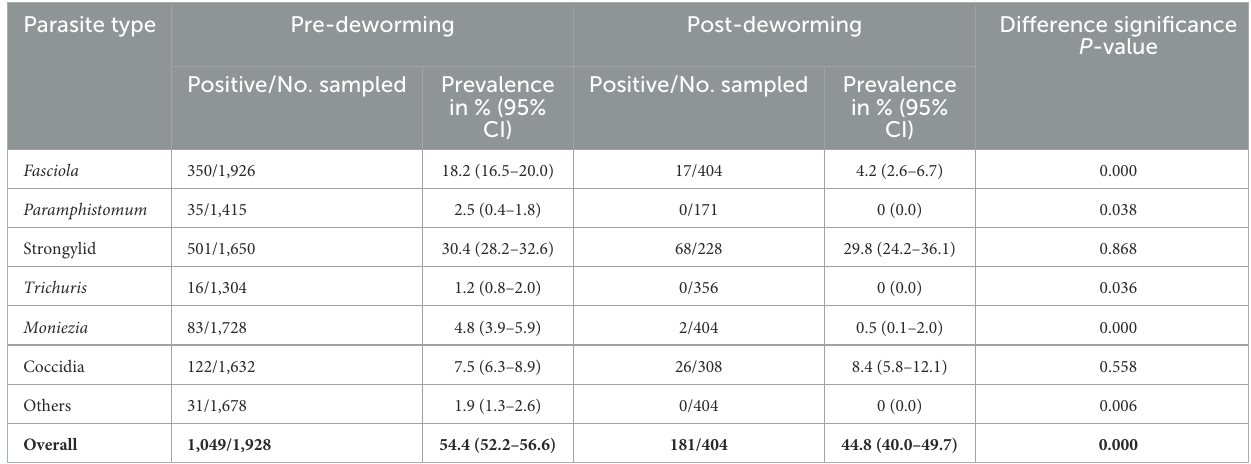
TABLE 6 Overall pre- and post-deworming GIT parasite prevalence.